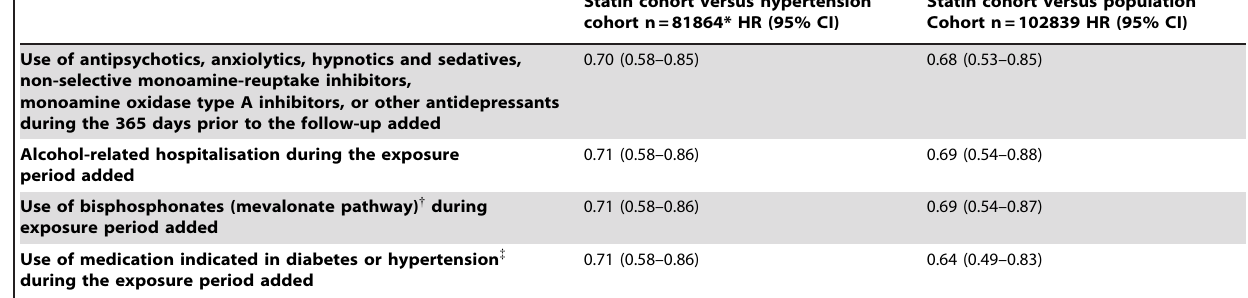
Table 6. Sensitivity